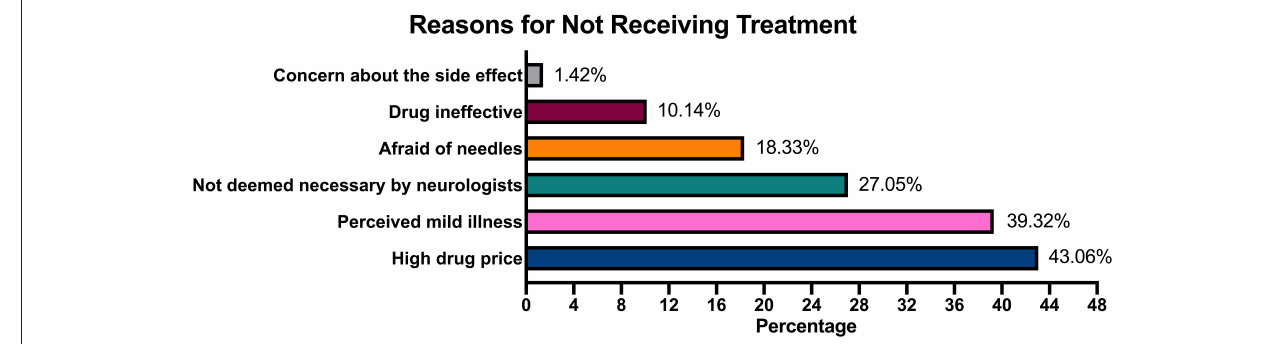
FIGURE 1 | Reasons for not receiving treatment.